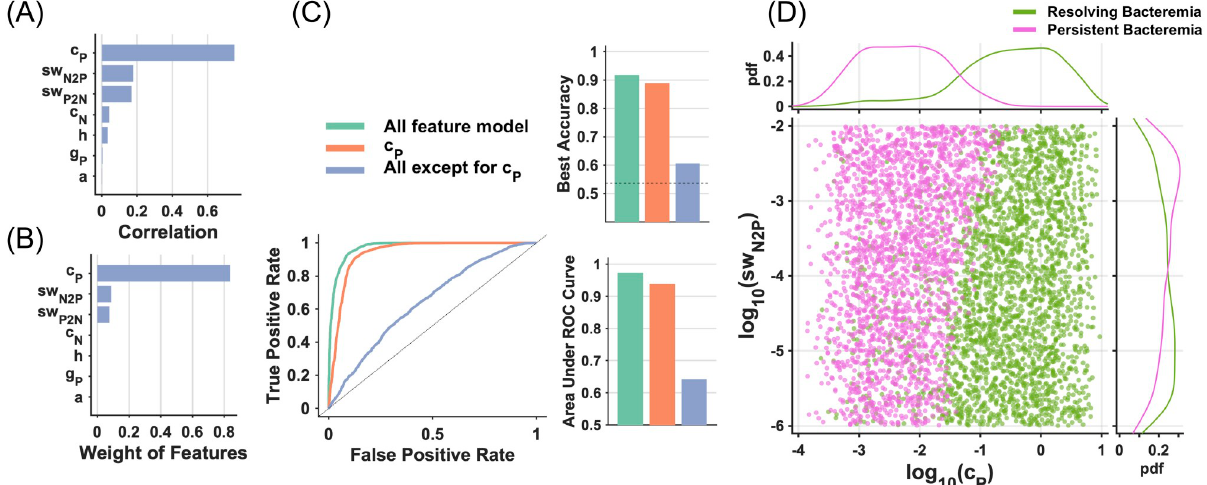
Fig 5. Key determinants to distinguish resolving and persistent bacteremia. (A) Pearson correlation coefficients were calculated between each feature and the binary response variable (0: RB, 1: PB). The absolute values of the coefficients are shown. (B) Weights calculated by QPFS methods are shown. (C) The sole ranked feature by QPFS, c P , was used to build a logistic regression model. For the comparison, all parameter and all parameter were applied to the classification model. Best accuracy, ROC curve, and area under ROC curve are graphed for each model. (D) Two- except for c P dimensional scatter plot for c P and sw N2P , which showed 2 nd high correlation with target response (Fig5 A) with probability density for RB and PB.